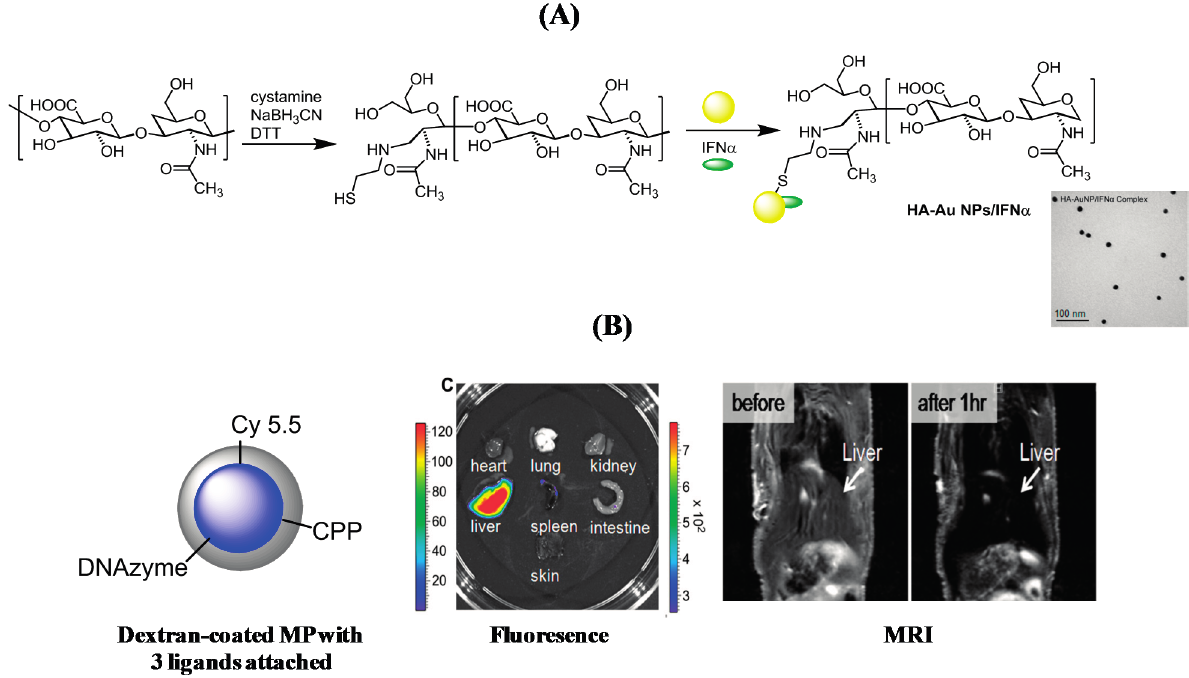
Figure 7. ( A ) Schematic representation for the preparation of thiol-ended HA and the formation of HA-Au NPs/IFN α nanostructures together with TEM image of the gold complex [87]; ( B ) A magnetic nanostructure linked to synthetic DNAzyme, Cy5.5, and a cell penetrating peptide (CPP), (left; fluorescence images of the extracted organs showing the particle accumulation in the liver (middle), T2-weighted MR images of a mouse before and after 1 h injection of the magnetic nanostructure (right) with accumulation in the liver (reprint permission from Ref.